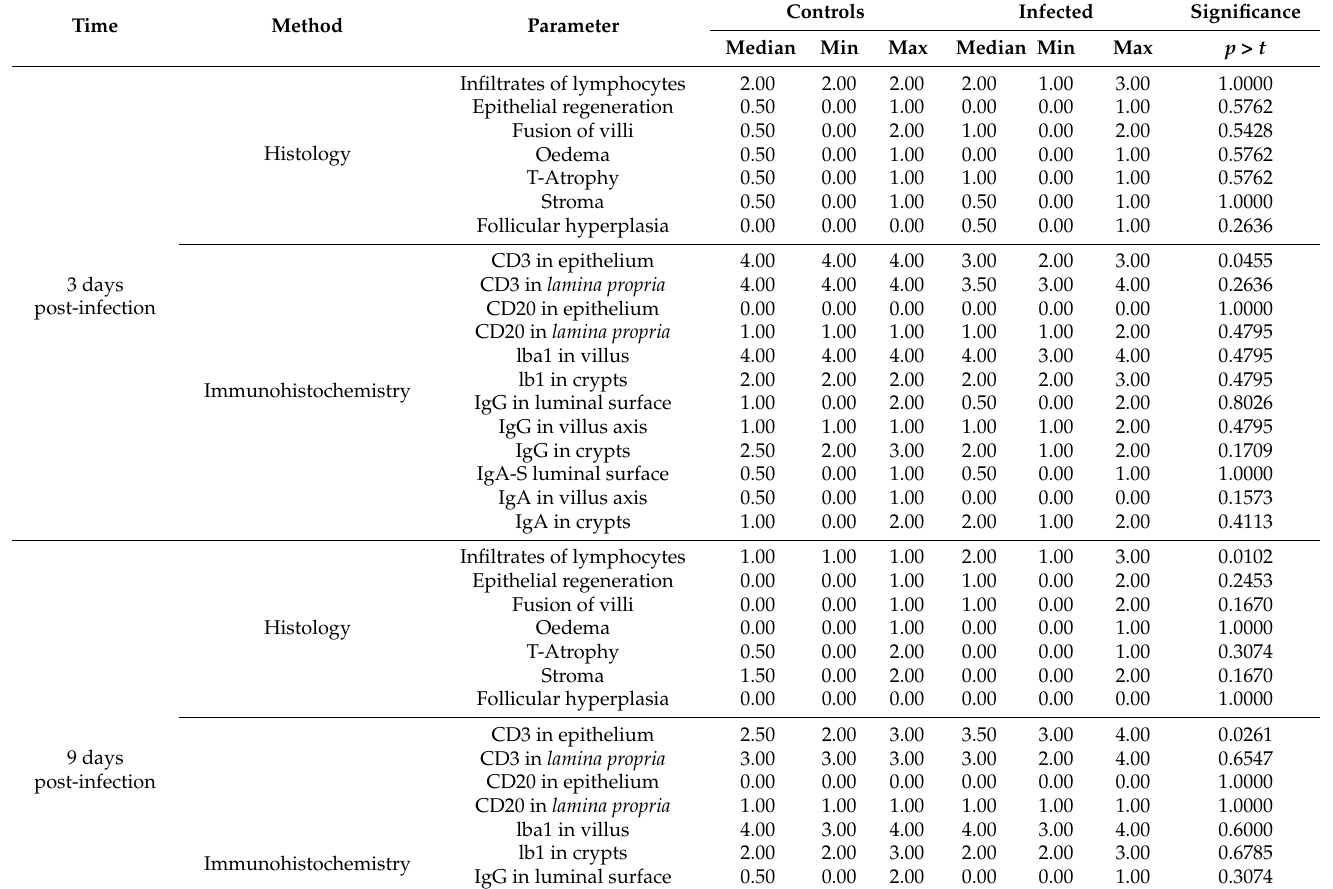
Table 4. Median parameters obtained in infected and controls at 3 and 9